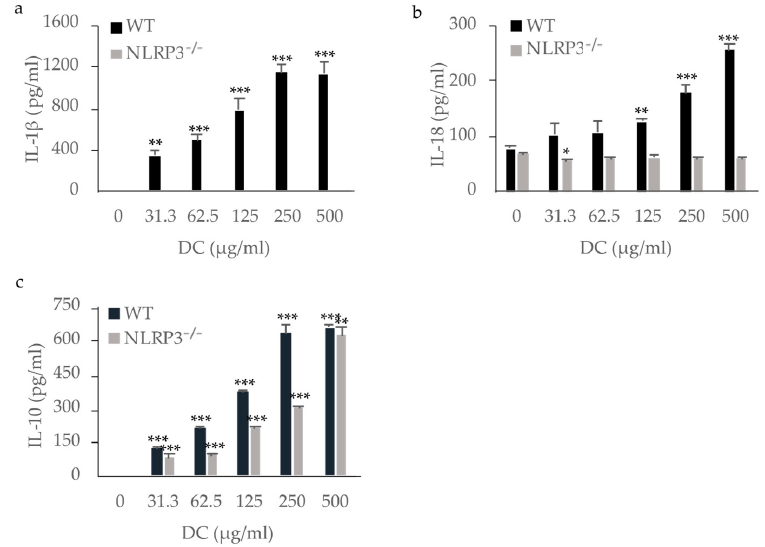
Figure 3. Production of IL-1 β , IL-18, and IL-10 by mouse macrophages stimulated with dental calcu- lus (DC). WT and NLRP3 − / − mouse macrophages were stimulated with DC for 8 h. The production of IL-1 β ( a ), IL-18 ( b ), and IL-10 ( c ) were measured by ELISA. The differences between the groups were analyzed by one-way ANOVA followed by a Tukey test for multiple comparisons. * p < 0.05 ** p < 0.01 *** p < 0.001 compared with the unstimulated control. WT, wild-type.